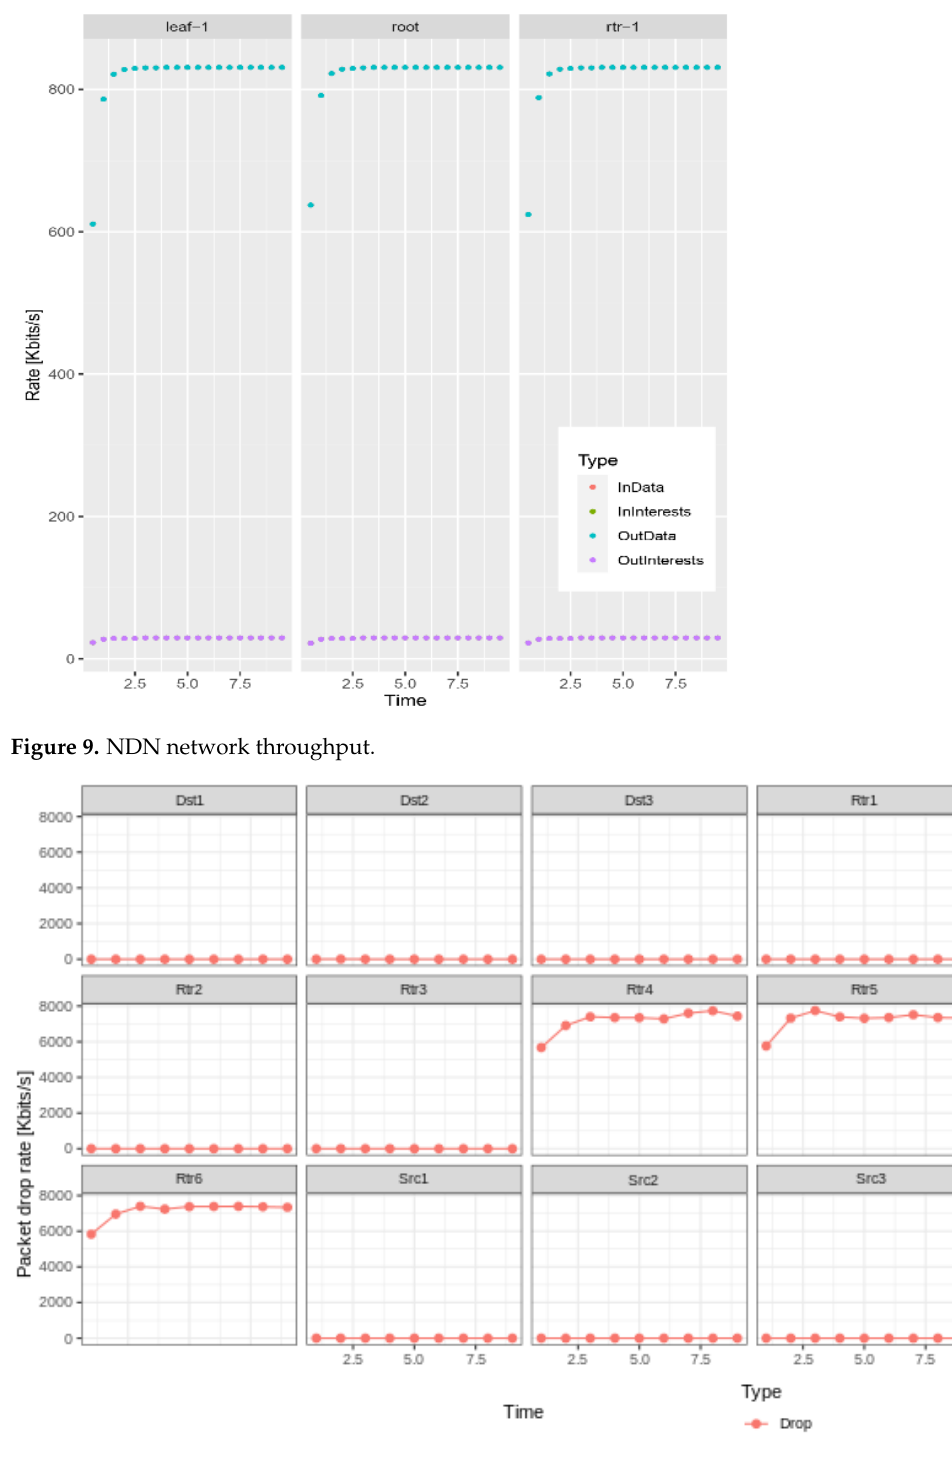
Figure 10. Packet loss rate of NDN network.